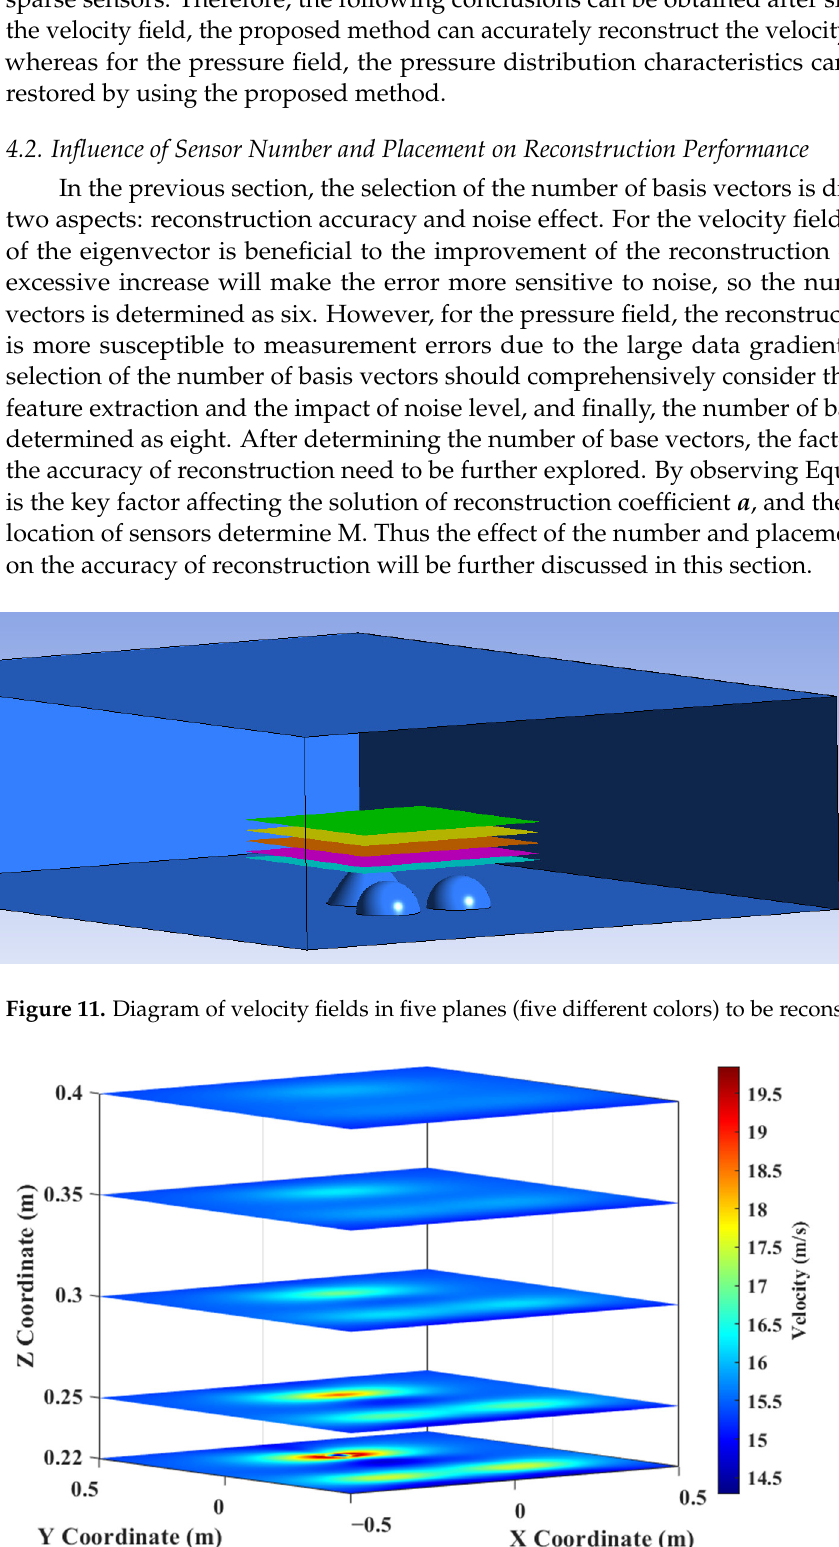
Figure 13. Velocity nephograms of reconstruction with boundary condition of 90°, 15 m/s.